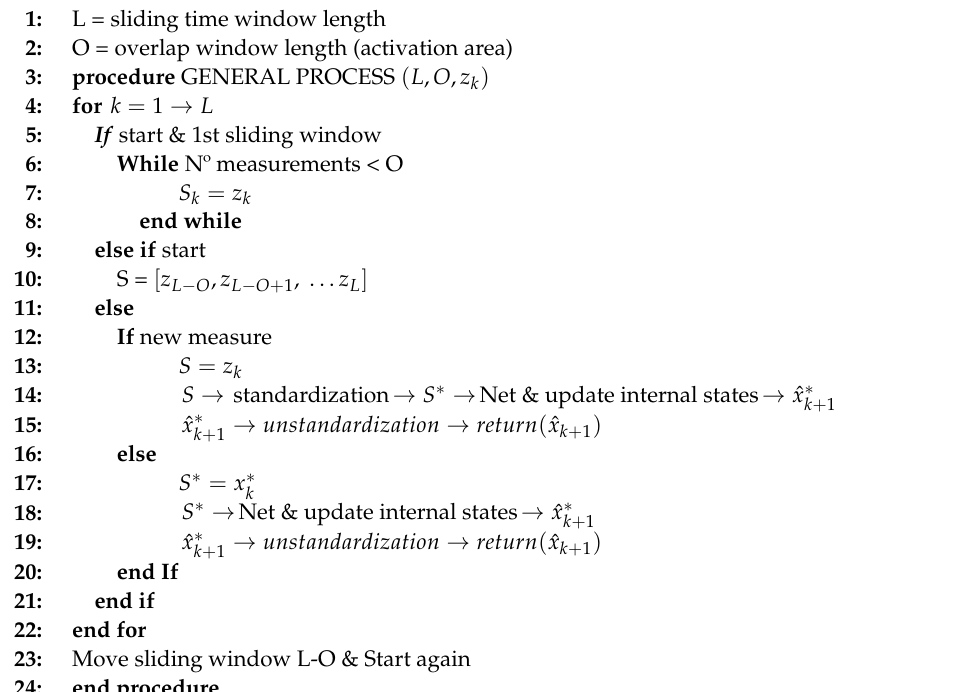
Algorithm 1. General proposal